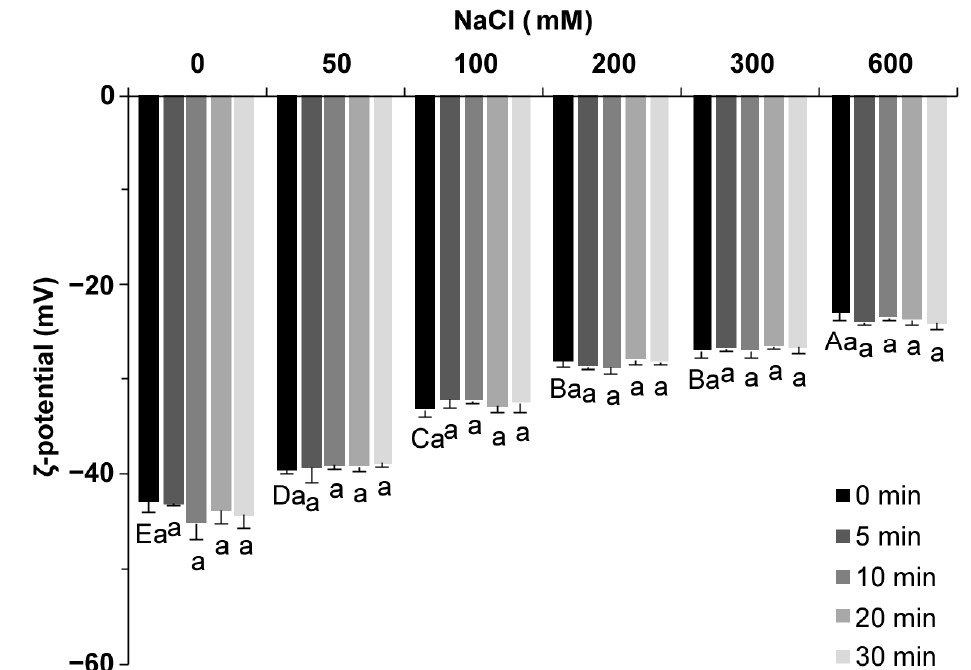
Figure 2. ζ potential of soy protein isolate treated with varying ultrasound processing times (0, 5, 10, 20, and 30 min) at different NaCl concentrations (0, 50, 100, 200, 300, and 600 mM). The upper letters indicate significant differences between the samples without ultrasound treatment in different salt concentrations. The lower letters indicate significant differences between the samples with different ultrasound times in the same salt concentration ( p < 0.05). Different letters indicate significant differences between groups ( p < 0.05).